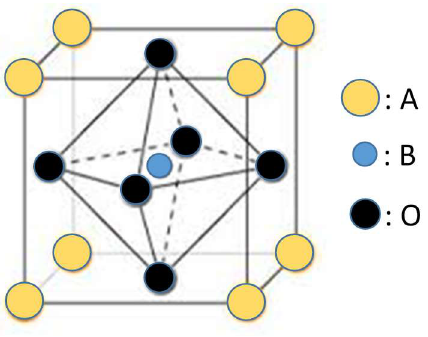
Figure 1. Unit cell of perovskite centred on